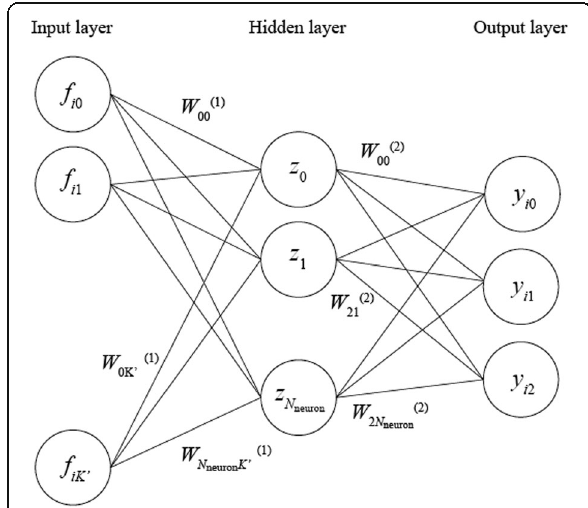
Fig. 6 A schematic view of the structure of the MLP used in this